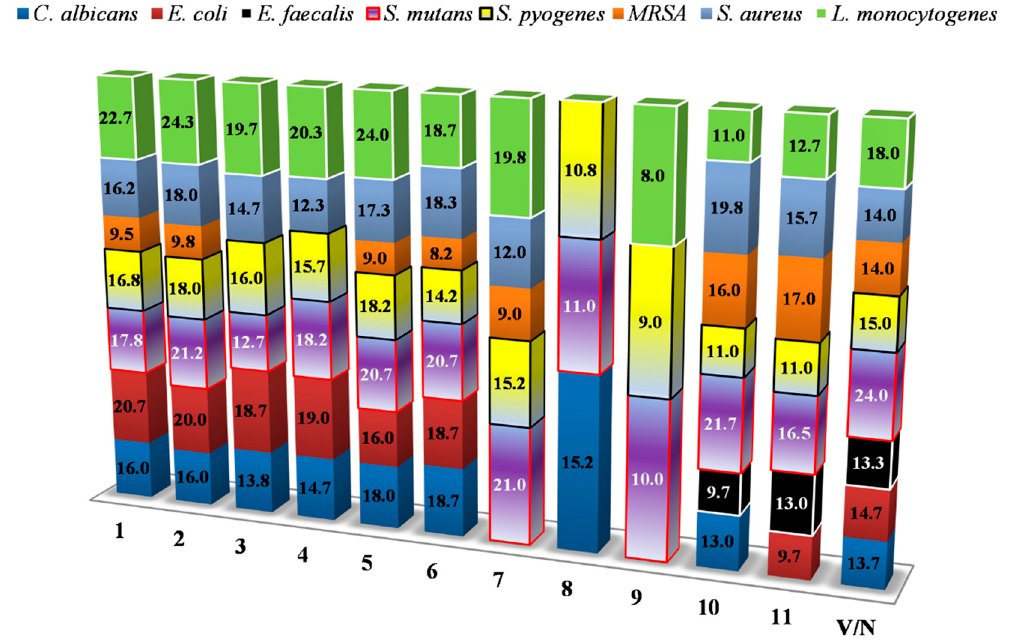
Figure 4. Antimicrobial potential of wood waste extracts in well-diffusion method. *V/N—Vancomycin/Nystatin. Values within columns represent a mean of inhibition zones and expressed in mm. Q. robur (no. 1–3), Q. petraea (no. 4–6), Q. cerris (no. 7), Robinia pseudoacacia (no. 8),